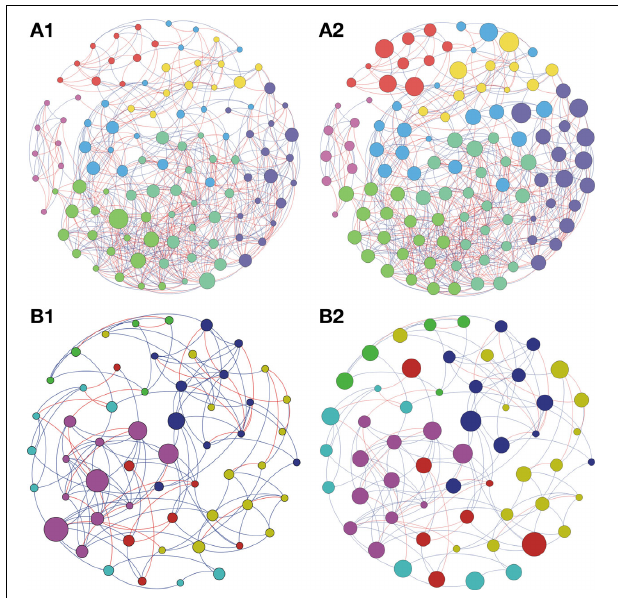
FIGURE 2 | Network interactions of soil bacterial genus found in the Natural forest (A1, A2) and in the Natural pasture (B1, B2) from site A on Pampa biome. A connection stands for a strong Pearson’s correlation ( p ≥ 0 . 9 and P -value ≤ 0.05). Each circle (usually called node) represents a bacterial genus and the sizes of the circles are proportional to the value of betweenness centrality in (A1) and (B1) . In (A2) and (B2) the sizes of the circles are proportional to value of closeness centrality. Lines connecting two bacterial genera represent the interactions between them. Blue lines represent the positive significant correlations and red lines represent a negative significant correlation. The colors of the circles represent the bacterial modules. For clarity, the OTU’s identity was omitted. Detailed networks containing the identity of each node can be observed in the Supplementary Figures S1–S5 and Supplementary Table